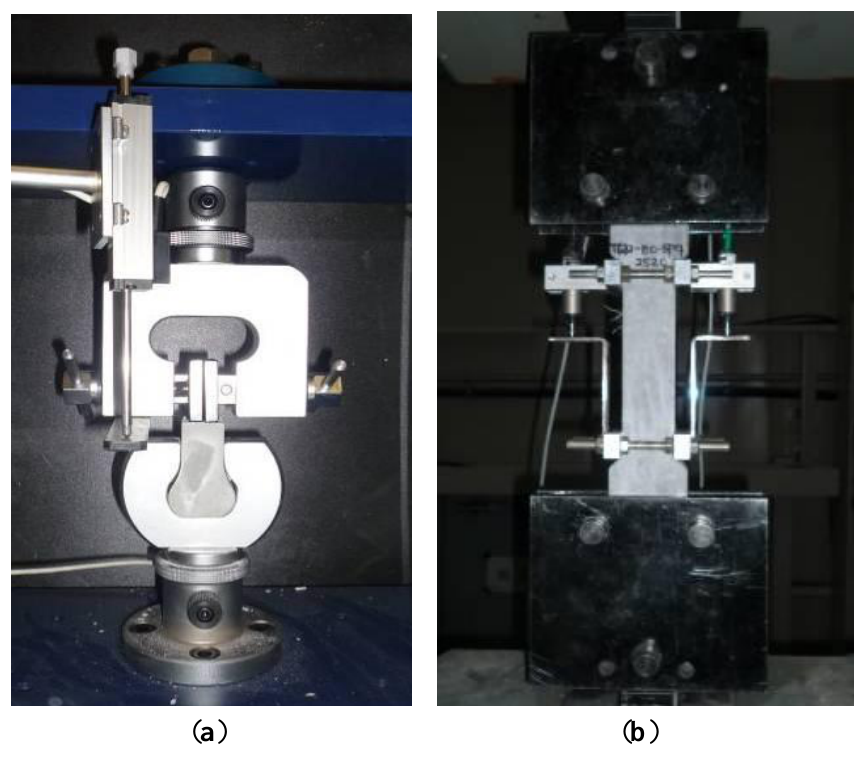
Figure 3. Test set-ups. ( a ) Pullout test; ( b ) Tensile